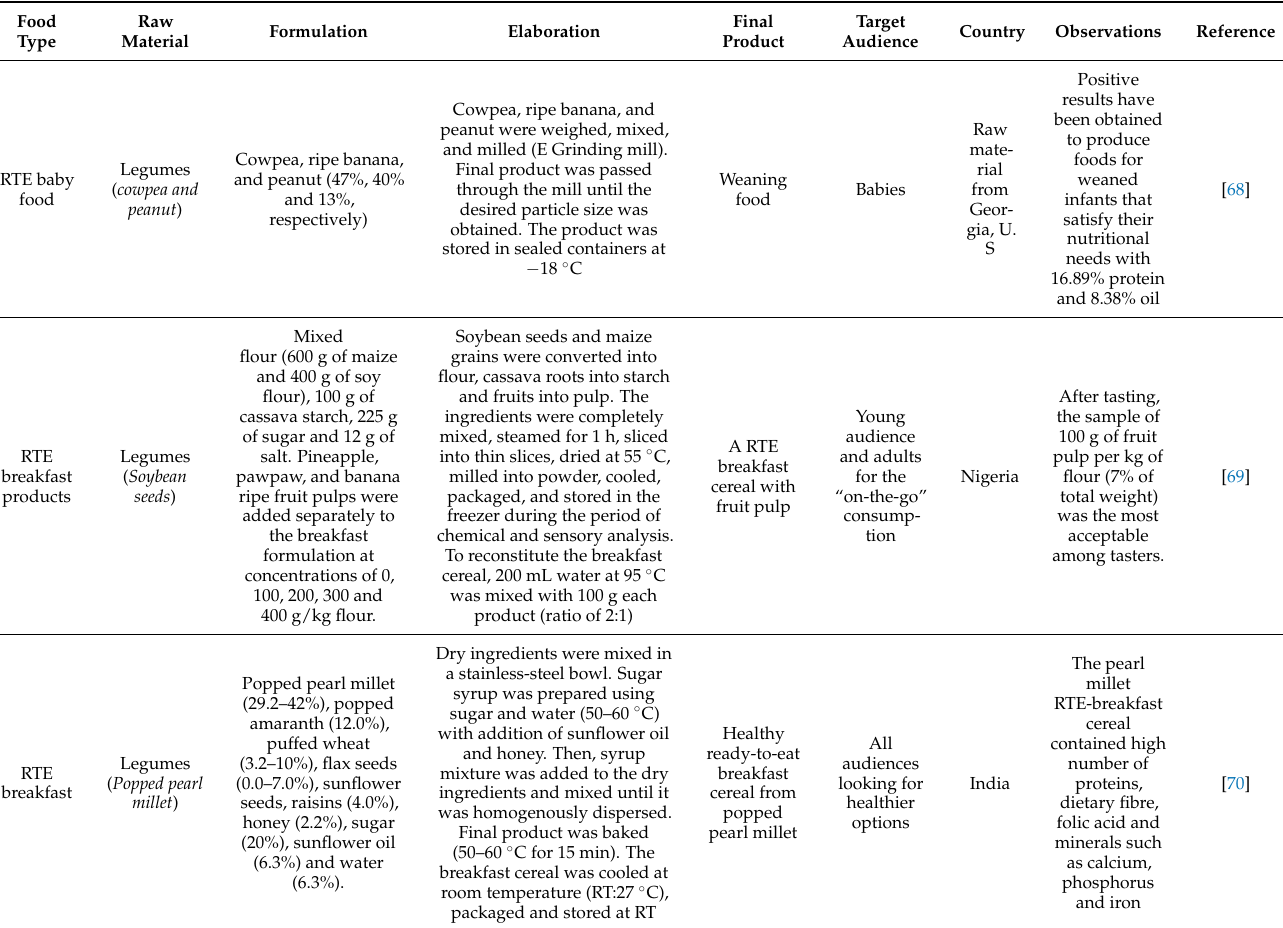
Table 1. Ready-to-eat products formulated with legumes and nuts available in the